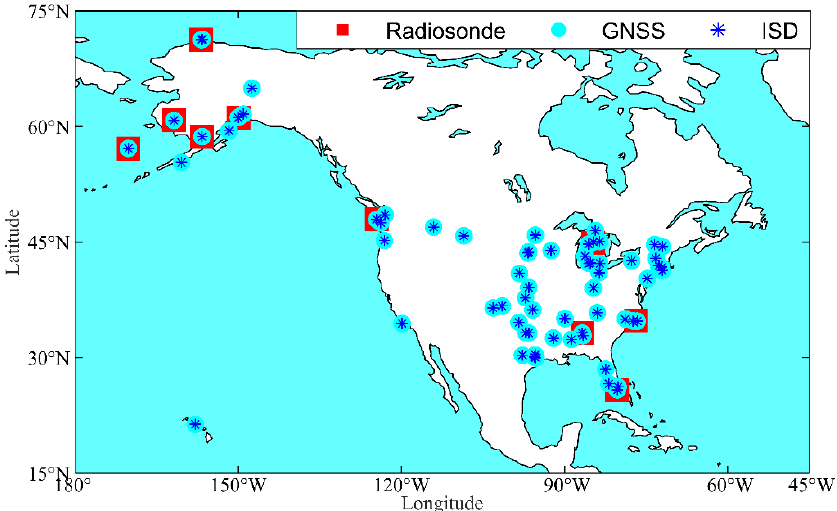
Figure 1. Distribution of stations used in this study. The red quadrangles, cyan circles, and blue asterisks stand for radiosonde, GNSS, and rainfall stations, respectively.